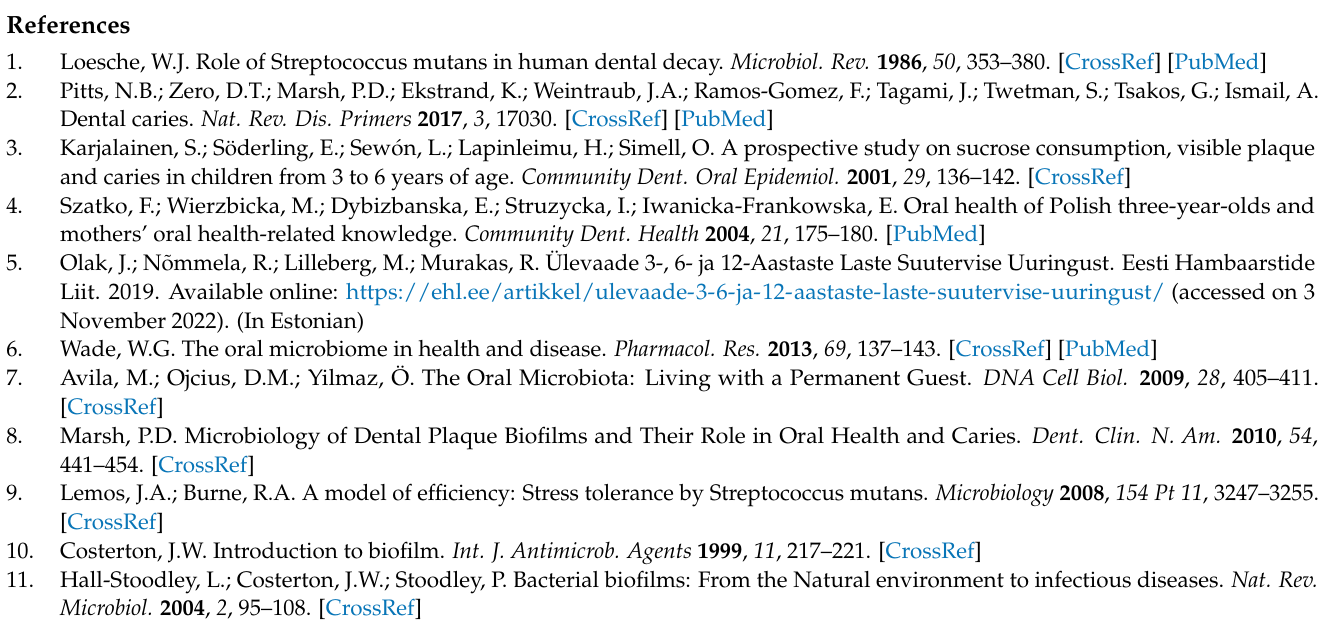
Table S2: Primers of virulence genes studied; Figure S1: A—Genotyped S. sobrinus strains. M1—SmaI enzyme; all strains are identified by their last three digits from their HUMB code; strains with similar gene patterns of mother and child are marked in blue (child 011-HUMB_13011, 012-HUMB_13012 and mother 105-HUMB_13105). Strain 018 is similar to latter strains, but the strain has been isolated from another individual. Strains 038 and 039 are isolated from the same caries site and also have the same gene pattern. The gene pattern of the previous strains are also similar to strain 104, but it is also isolated from another individual. Among the strains were three pairs of bacterial strains from the same individuals. Since the two pairs of strains also had a similar gene pattern, the two replicates were removed from further analysis. Two strains of S. sobrinus with different gene patterns were isolated from a third person, so both strains were included in the analysis. Thus, 37 human information but 38 bacterial strains were included into the study. B—Genotyped S. mutans strains. M2—ApaI enzyme; all strains are identified by their last three digits from their HUMB